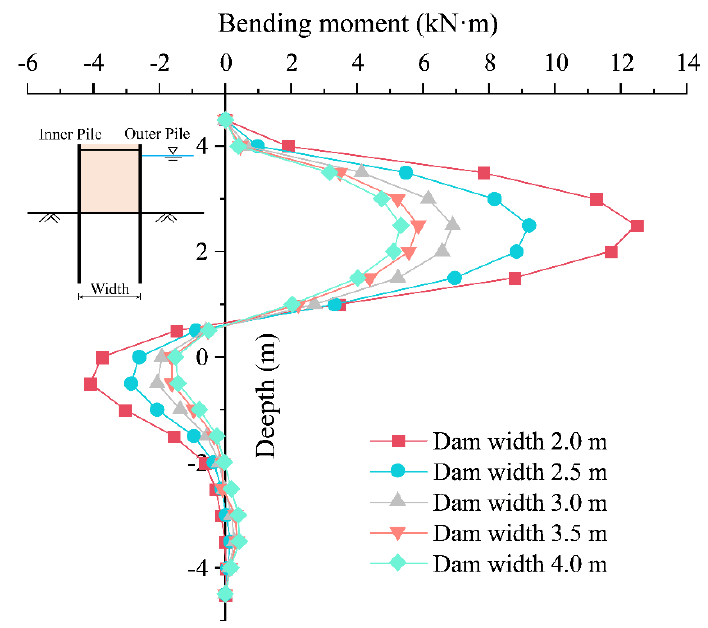
Figure 16. Pile bending moment of different dam width conditions.